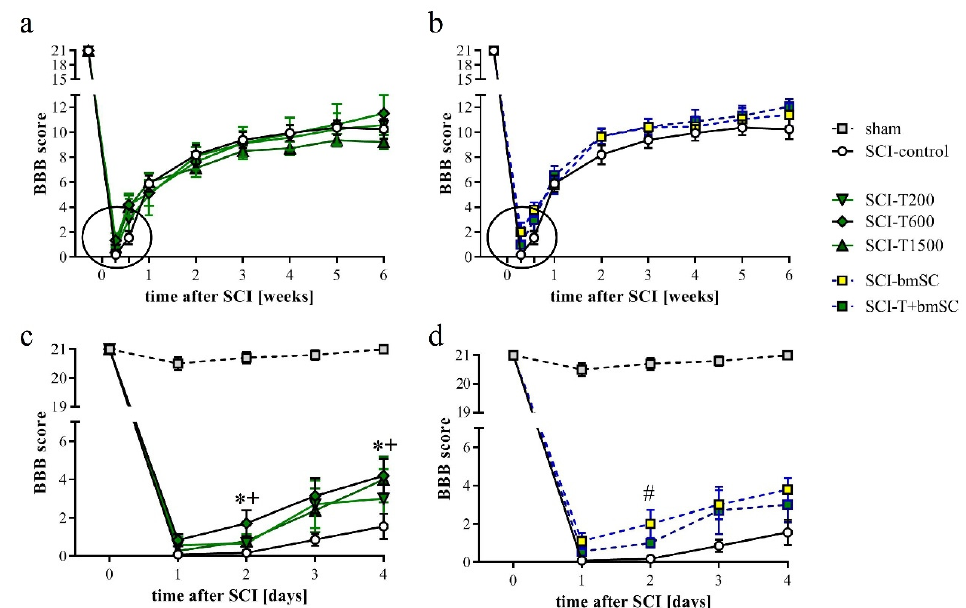
Figure 3. Recovery of motor functions after SCI assessed in the open field. Mean BBB scores were monitored before surgery, daily during the first 4 dpo after surgery, and then once per week during 6 weeks of evaluation. ( a ) Results for SCI-control, treated with saline, and the TUDCA treated groups. ( b ) Results for SCI-control and the SCI groups treated with bmSC and TUDCA + bmSC. ( c , d ) Changes in the acute/subacute phase; effects of treatment with 2 × 300 mg/kg TUDCA or with bmSC were significant at 2 dpo and/or 4 dpo [see main text for statistical evaluation; * (SCI-T600), + (SCI-T1500), # (SCT-bmSC) indicate p < 0.05; error bars indicate SEM]. Recovery of motor function improved in all treatment groups until a plateau was reached after three weeks; experimental groups are indicated as for Figure 2.